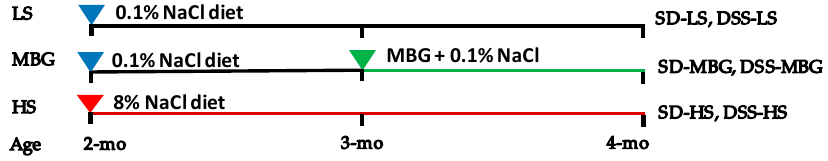
Figure 1. Schematic presentation of the experimental design and the group description. Sprague– Dawley (SD) and Dahl salt-sensitive (DSS) rats received a low-salt (LS) diet for 8 weeks, a high-salt (HS) diet for 8 weeks, or marinobufagenin (MBG), which was administered via osmotic minipumps for 4 weeks. The MBG-treated rats received an LS diet for the duration of the study.